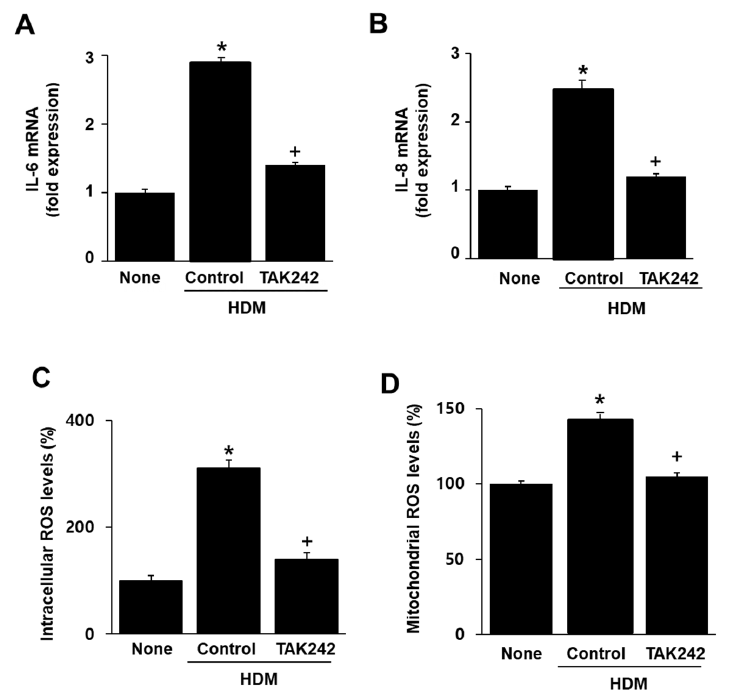
Figure 5. Effects of TAK242 on the mRNA expression of IL-6 and IL-8 and intracellular and mitochondrial ROS levels in human dust mite (HDM)-stimulated A549 cells. ( A , B ) Cells were pretreated with TAK242 (0.5 µ M) for 1 h and then treated with HDM (20 µ g/mL) for 8 h. mRNA expression of IL-6 and IL-8 was determined with RT-PCR analysis. The mRNA levels in cells without any treatment (none) were set as 1. ( C , D ) Cells were pretreated with TAK242 (0.5 µ M) for 1 h and then treated with HDMs (20 µ g/mL) for 2 h. ( C ) Intracellular ROS levels were determined using DCF-DA. ROS levels in the cells without any treatment (none) were set as 100%. ( D ) Mitocondrial ROS levels were determined using MitoSOX. ROS levels in the cells without any treatment (none) were set as 100%. All data are shown as the mean ± S.E. of three independent experiments. * p < 0.05 vs. none (cells without any treatment); + p < 0.05 vs. control (cells with HDM